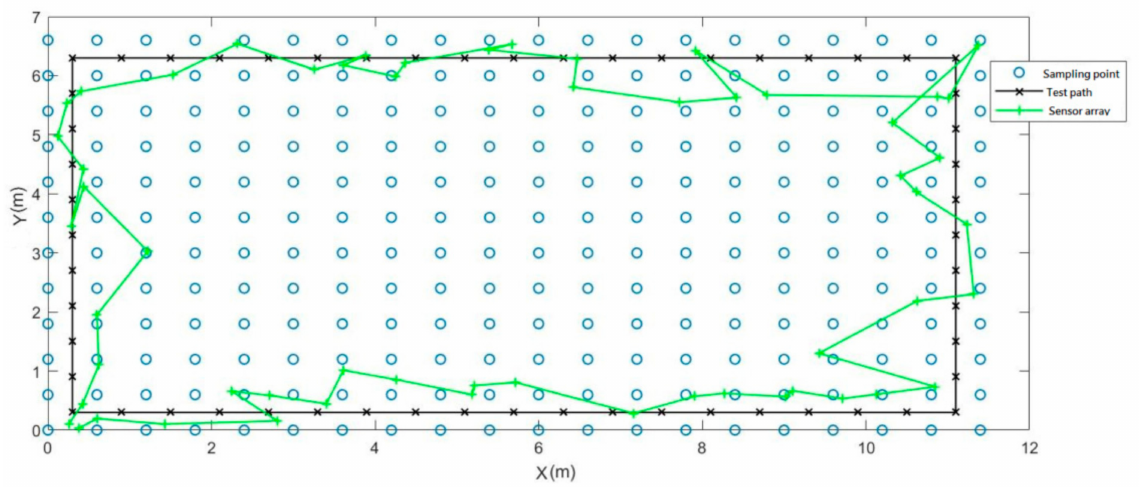
Figure 14. Indoor positioning experiment of magnetic sensor